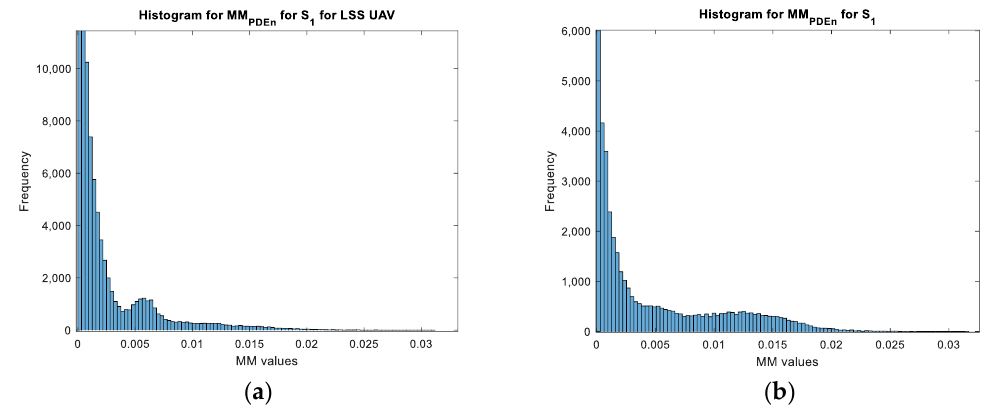
Figure 13. Zoom of the histograms from Figure 11c and Figure 12c: ( a ) LSS UAV Figure movement; ( b ) human movement.